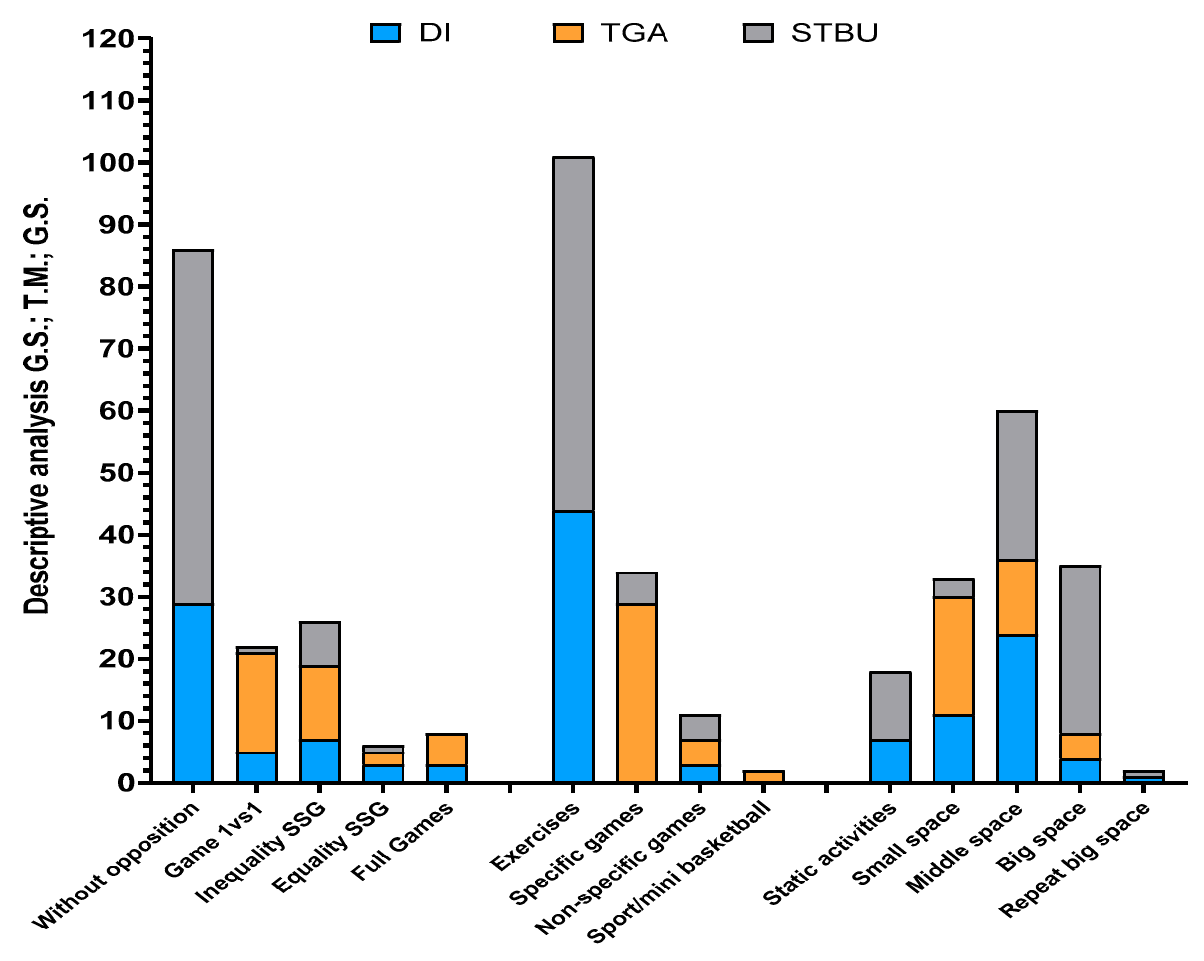
Figure 2. Descriptive analysis of intervention programs according to pedagogical variables. Note: DI, Direct instruction; TGA, Tactical Game Approach; STBU, Service Teacher´s Basketball Unit; SSG, Small-Sided Games.